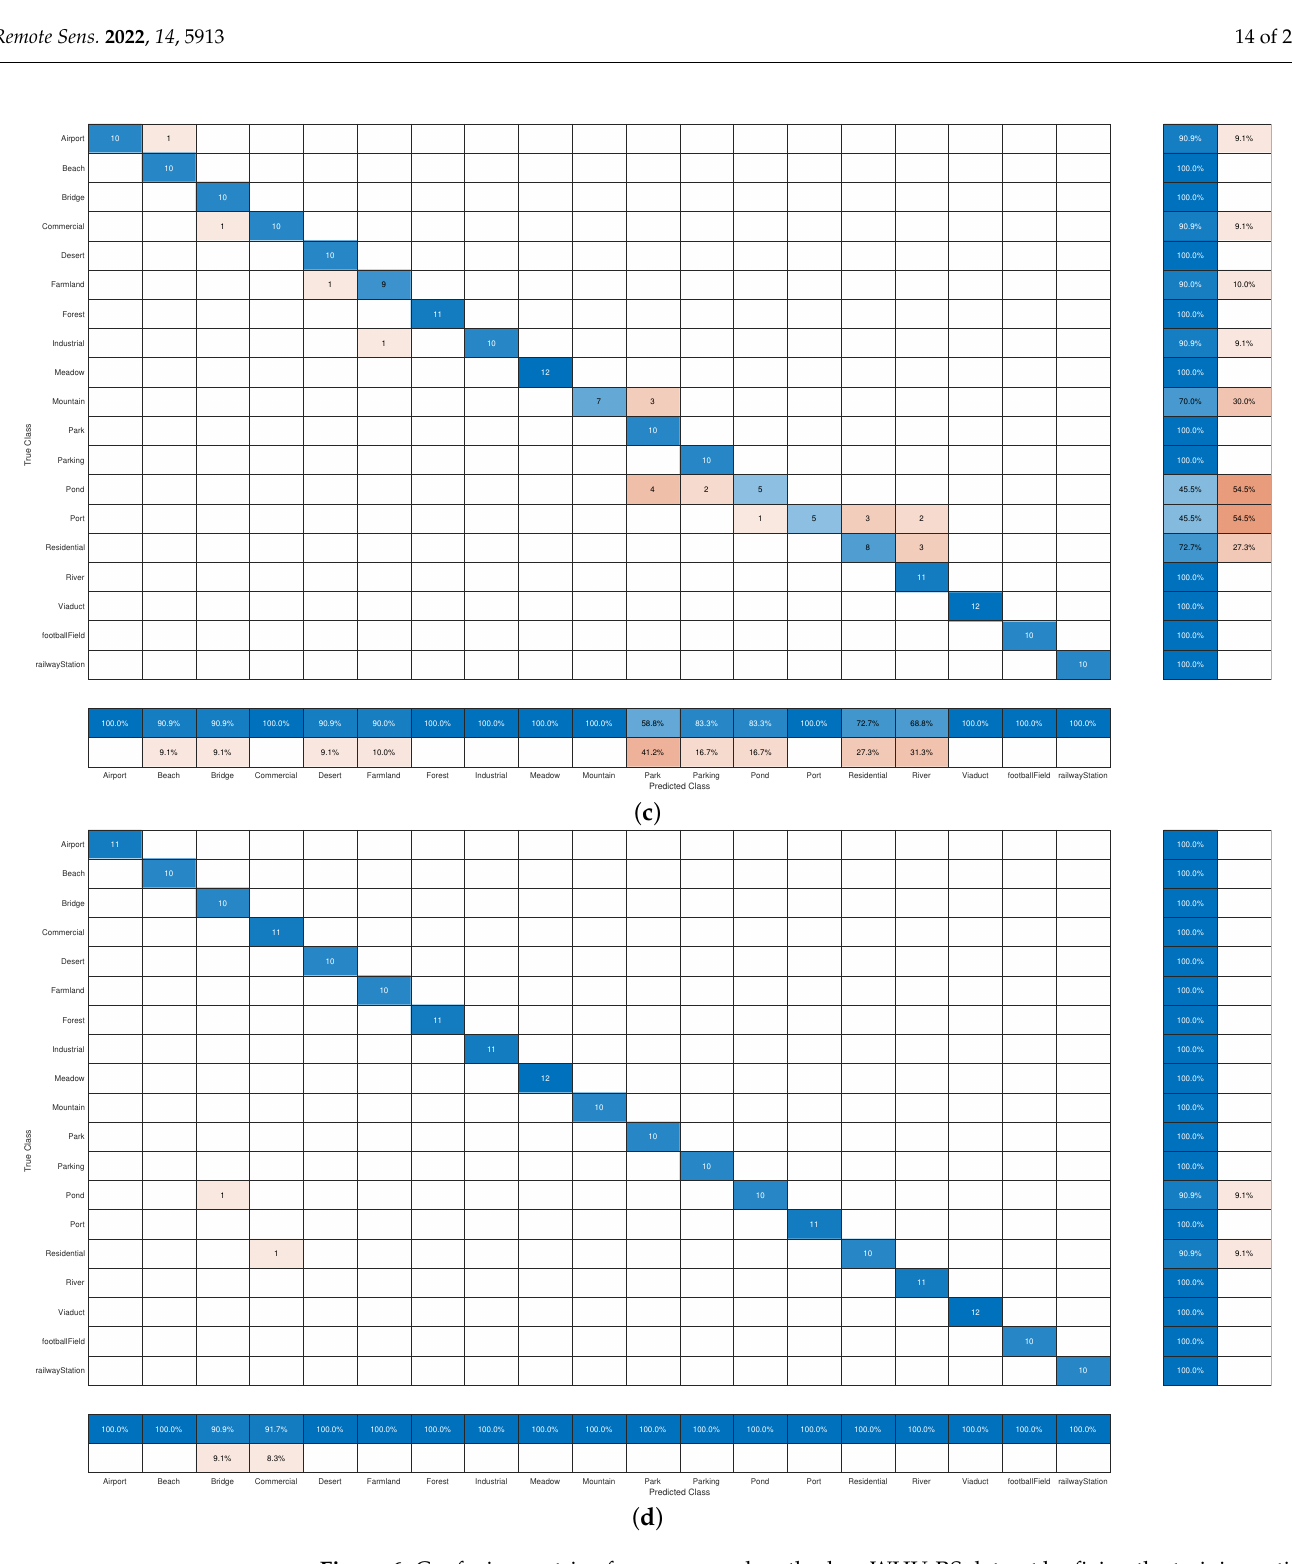
Figure 6. Confusion matrix of our proposed method on WHU-RS dataset by fixing the training ratio as 80% training ( a ) with one-stage learning, ( b ) with two-stage learning, ( c ) with three-stage learning, and ( d ) with multi-stage learning. Zoom in for a better